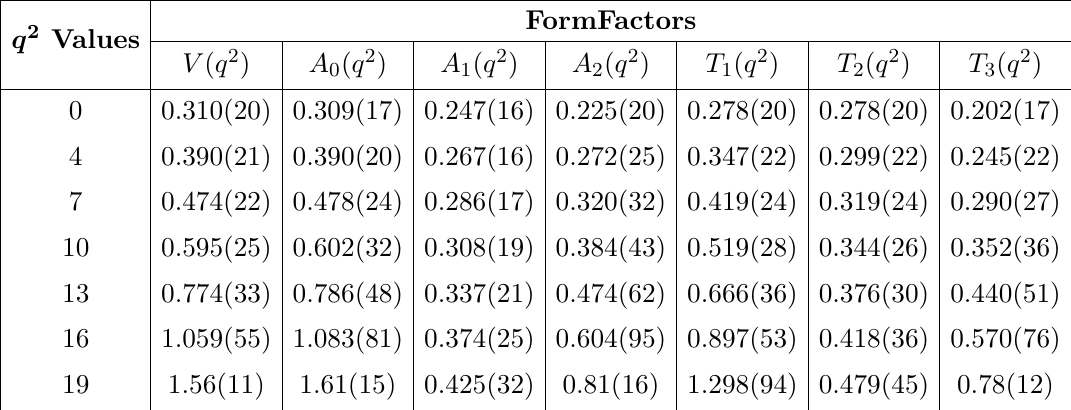
Values of the different B → ρ form factors (for n=3) corresponding to a few q 2 values within the allowed kinematical region for the B → ρ semileptonic transitions. The tensorial form factors are constrained by Lattice only and are completely unaltered after the inclusion of the normalized binned experimental data. This result is obtained from a fit that excludes the Babar data.